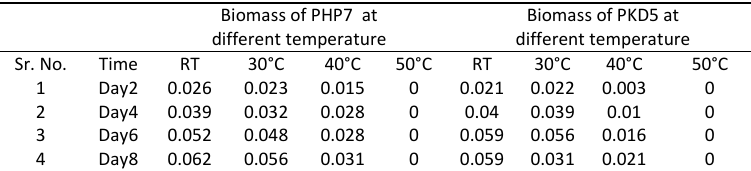
Biomass of PKD5 at different temperature